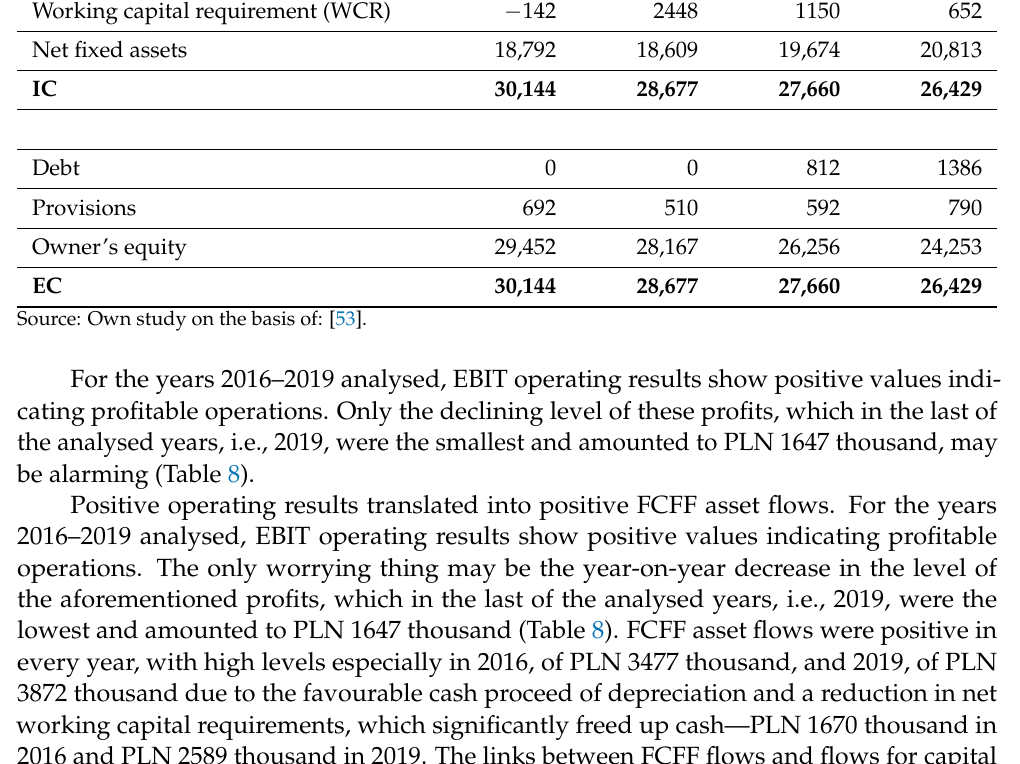
Table 8. Formation of FCFF, FCFE and FCD flows and the components affecting them in Geotermia